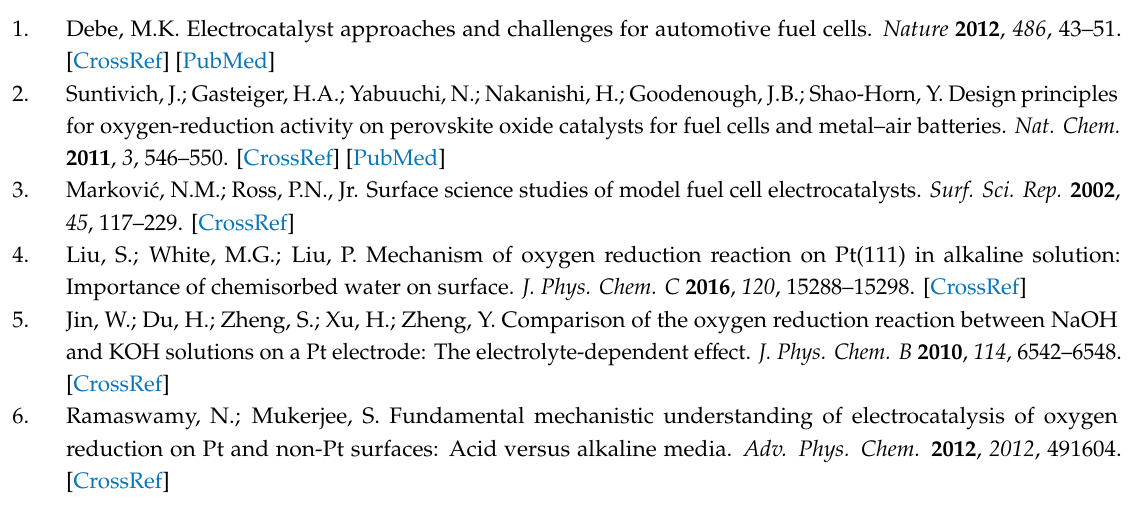
Figure S1. ∆ µ XANES spectra for the catalyst calculated by µ p ( E ) − µ 0.34V ( E ) where µ 0.34V ( E ) is a spectrum in 1 M KOH saturated with N 2 ; Figure S2. RCD curves for the controlled potential above 0.74 V in 1 M KOH saturated with N 2 . The standard potentials are 0.74, 0.94 and 1.19 V. Circle and square curves represent the negative and two positive peaks of 11566.75 eV, 11567.5 eV and 11569.75 eV, respectively. The dashed lines are complement of the explanation for RCD; Figure S3. RCD curves for the controlled potential above 0.74 V in 1 M KOH saturated with O 2 . The standard potentials are 0.74, 0.94 and 1.19 V. Circle and square curves represent the negative and two positive peaks of 11566.75 eV, 11567.5 eV and 11569.75 eV, respectively. The dashed lines are complement of the explanation for